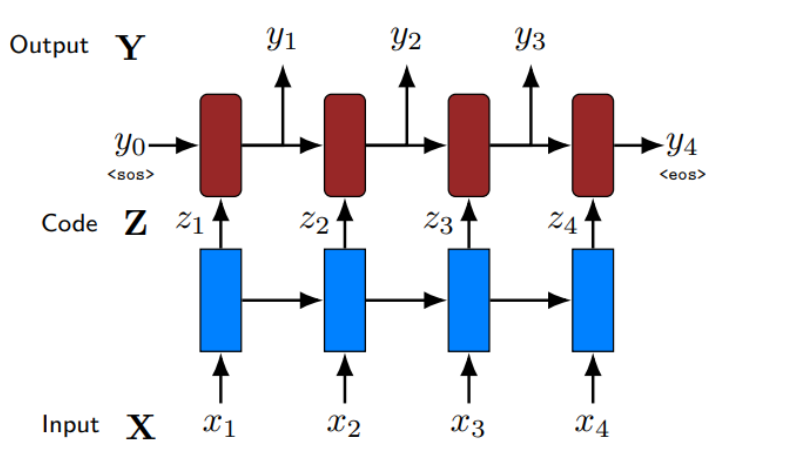
Figure 3. An encoder–decoder